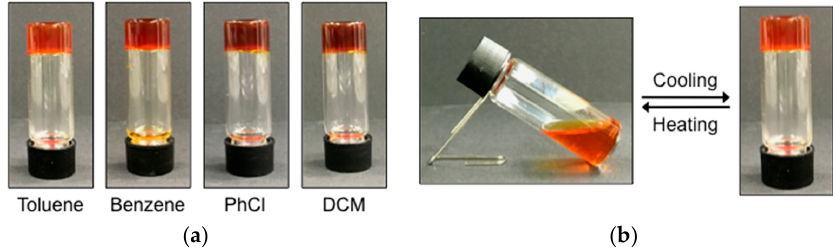
Figure 2. ( a ) Photographs of upside-down vials having selected gels made of 14 in toluene, benzene,